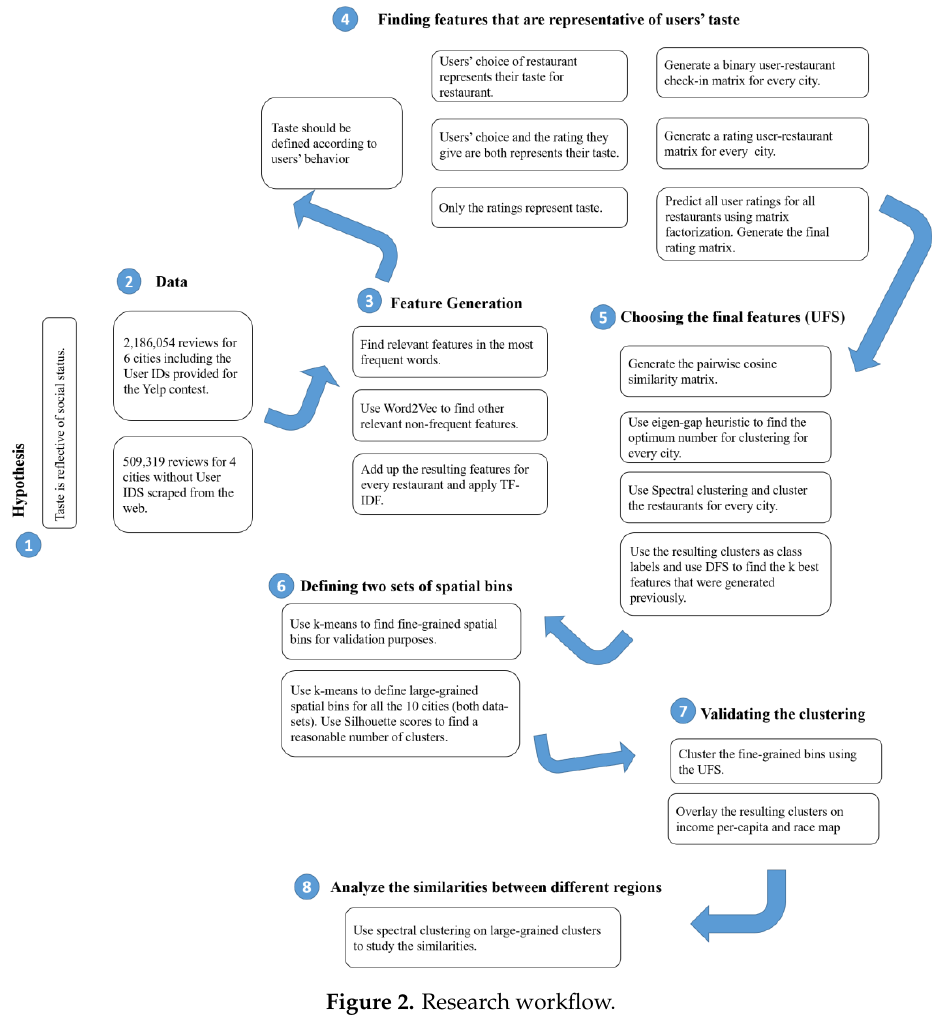
Figure 2. Research workflow.